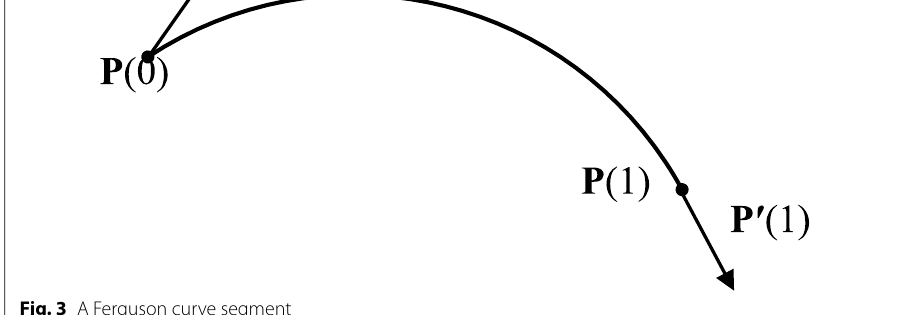
Fig. 3 A Ferguson curve segment